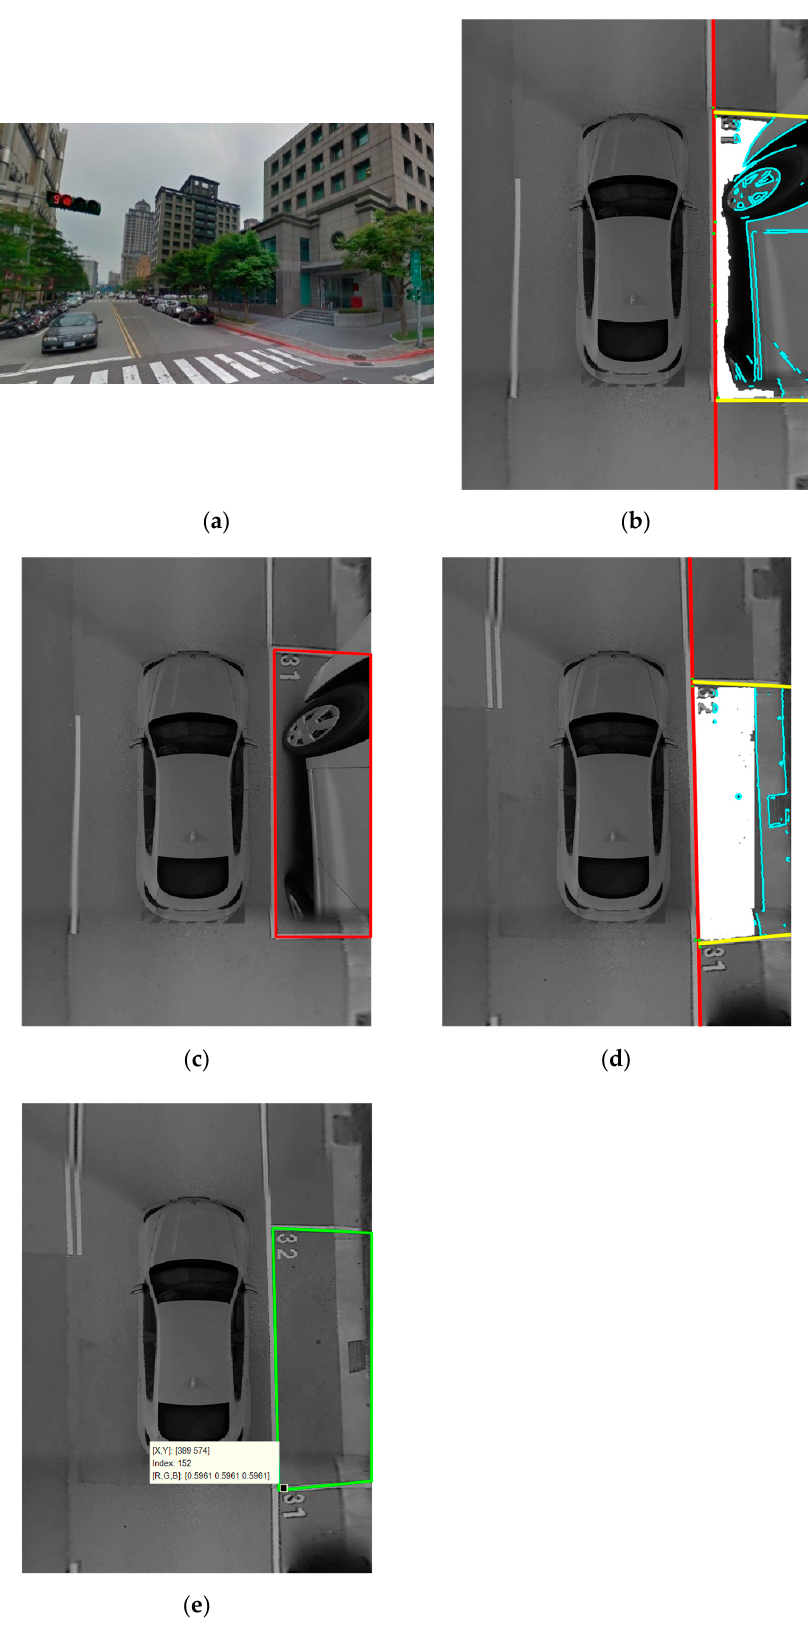
Figure 25. Experimental results for urban roadside parking spaces. ( a ) Experimental setting; ( b ) Detection process; ( c ) Detection results; ( d ) Detection process; ( e ) Detection results.